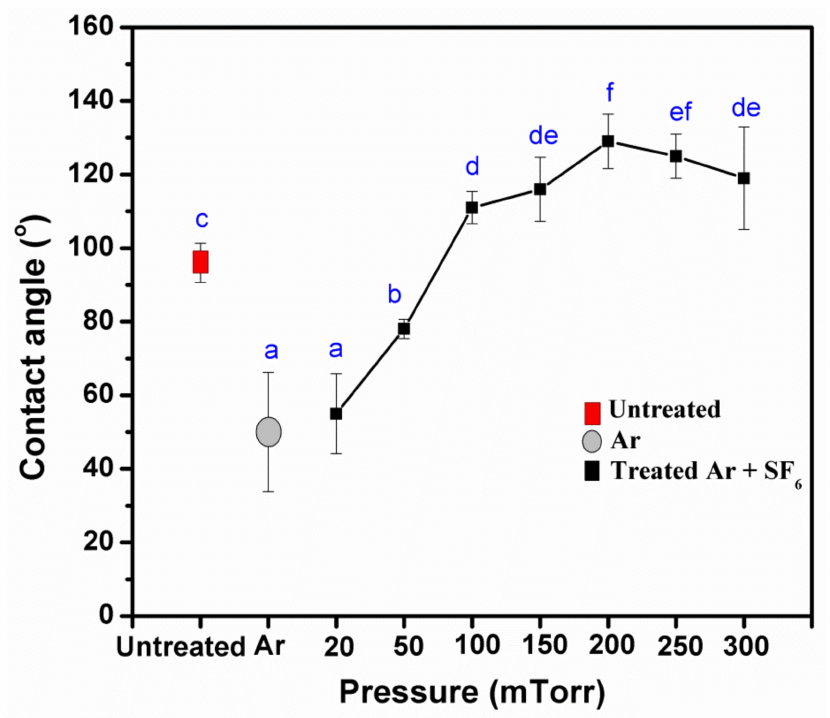
Figure 2. Effect of pressure on the contact angles of untreated and treated KPs with plasma at 50 Watts for 5 min. Note: values indicated with the same letters are not significantly different at p <